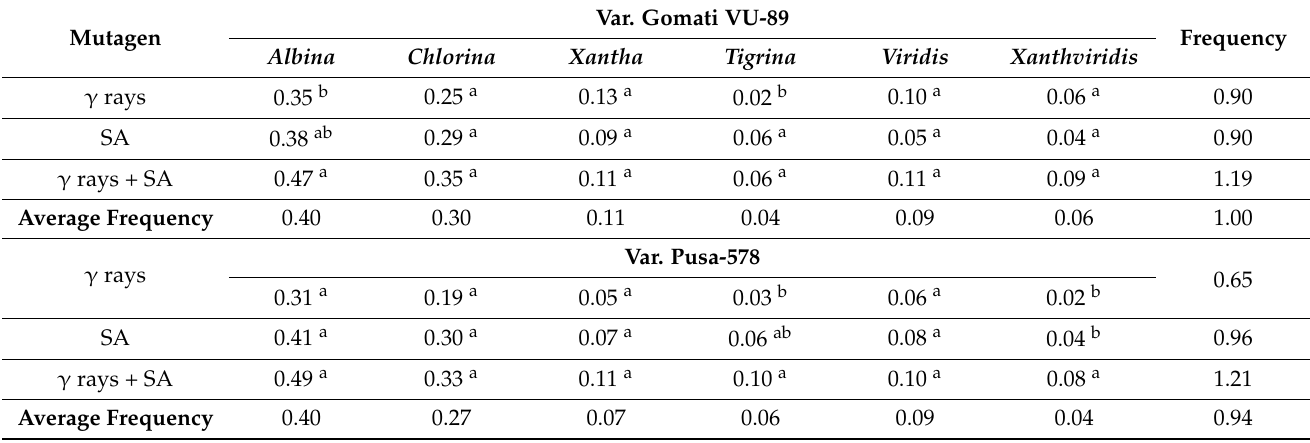
Table 3. Comparative frequency and spectrum of chlorophyll mutants (pooled data).